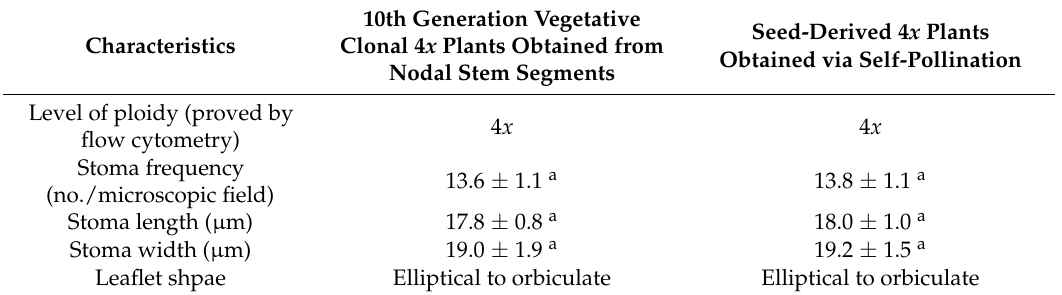
Table 6. Evaluation of ploidy stability on vegetative clonal and seed-derived 4 x plants of Salvia miltiorrhiza.